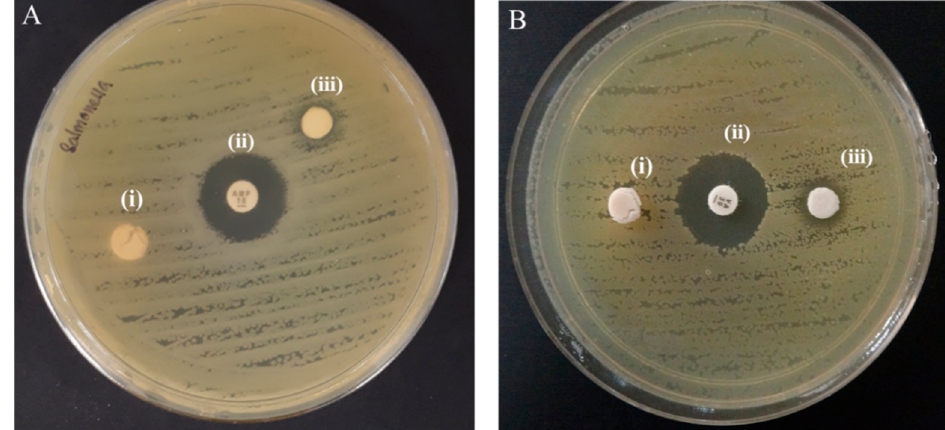
Figure 6. ( A ) Disc diffusion test with S. typhi and respective discs (i) pure CNF, (ii) vancomycin, and (iii) CNF-ZnO pH 10. ( B ) Disc diffusion test with MRSA and respective discs (i) pure CNF, (ii) vancomycin, and (iii) CNF-ZnO pH10.